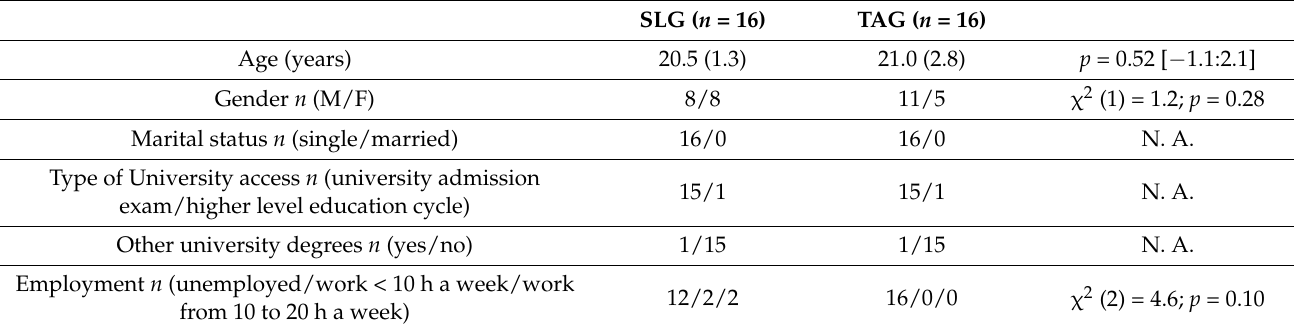
Table 1. Participants